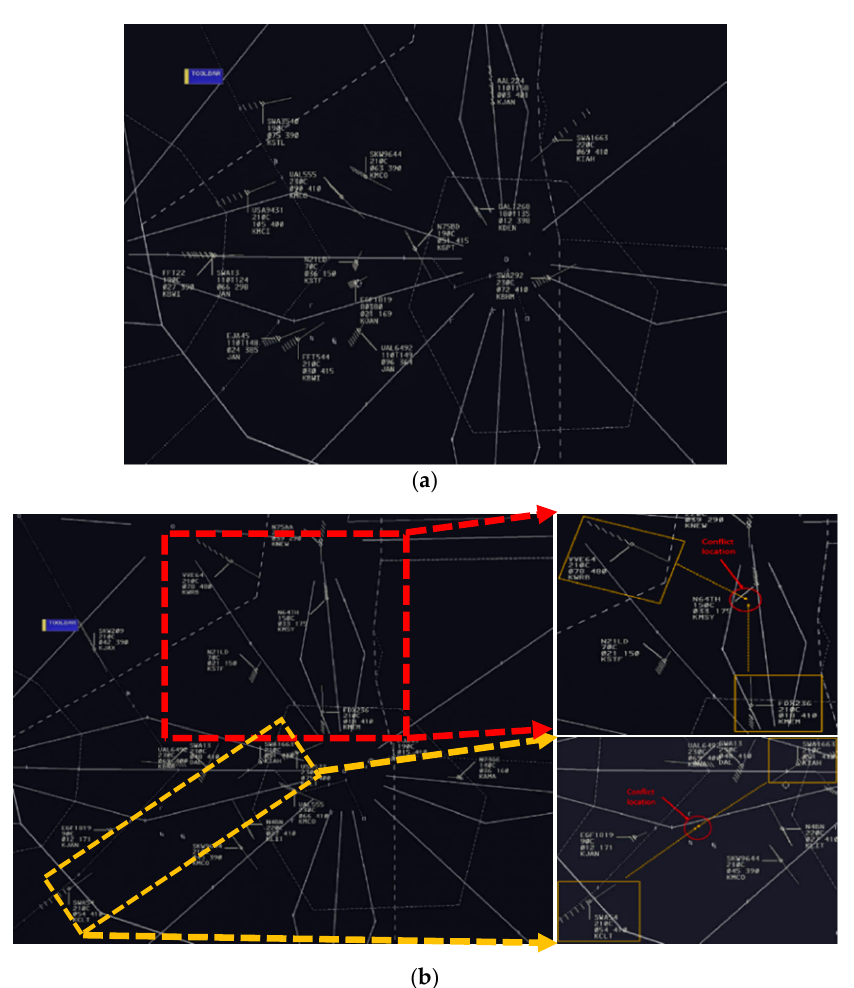
Figure 2. Example scenarios: ( a ) Layout of aircraft during an experiment using one of the scenarios; ( b ) Example of aircraft conflicts highlighted in red and yellow (left side shows the aircraft layout at a certain point in time, and the right side shows the future conflict